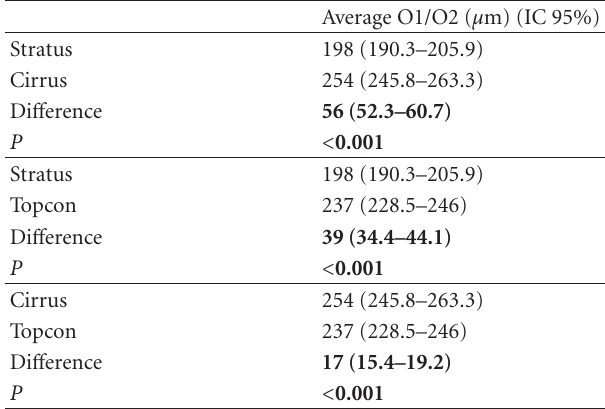
Table 2: Comparison of central macular thickness averages obtained by each OCT instrument (ANOVA).